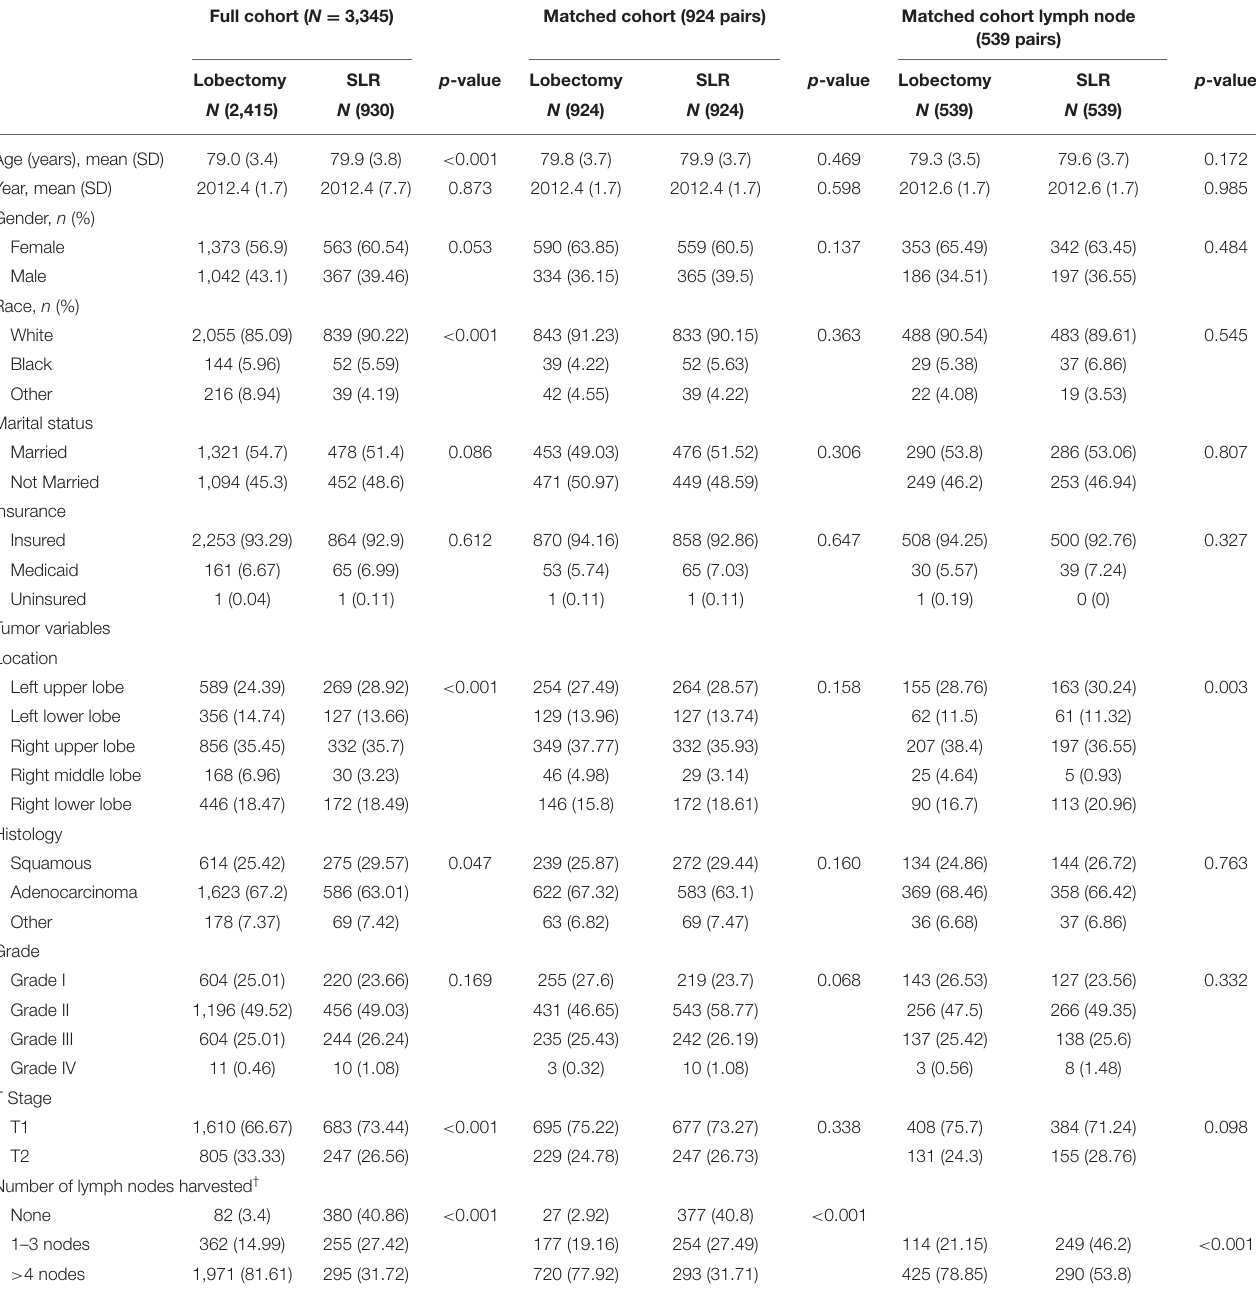
TABLE 1 | Characteristics of patients undergoing lobectomy and SLR for lung cancer of pathologic stage I in full cohort and two major propensity matched cohorts. Full cohort ( N =